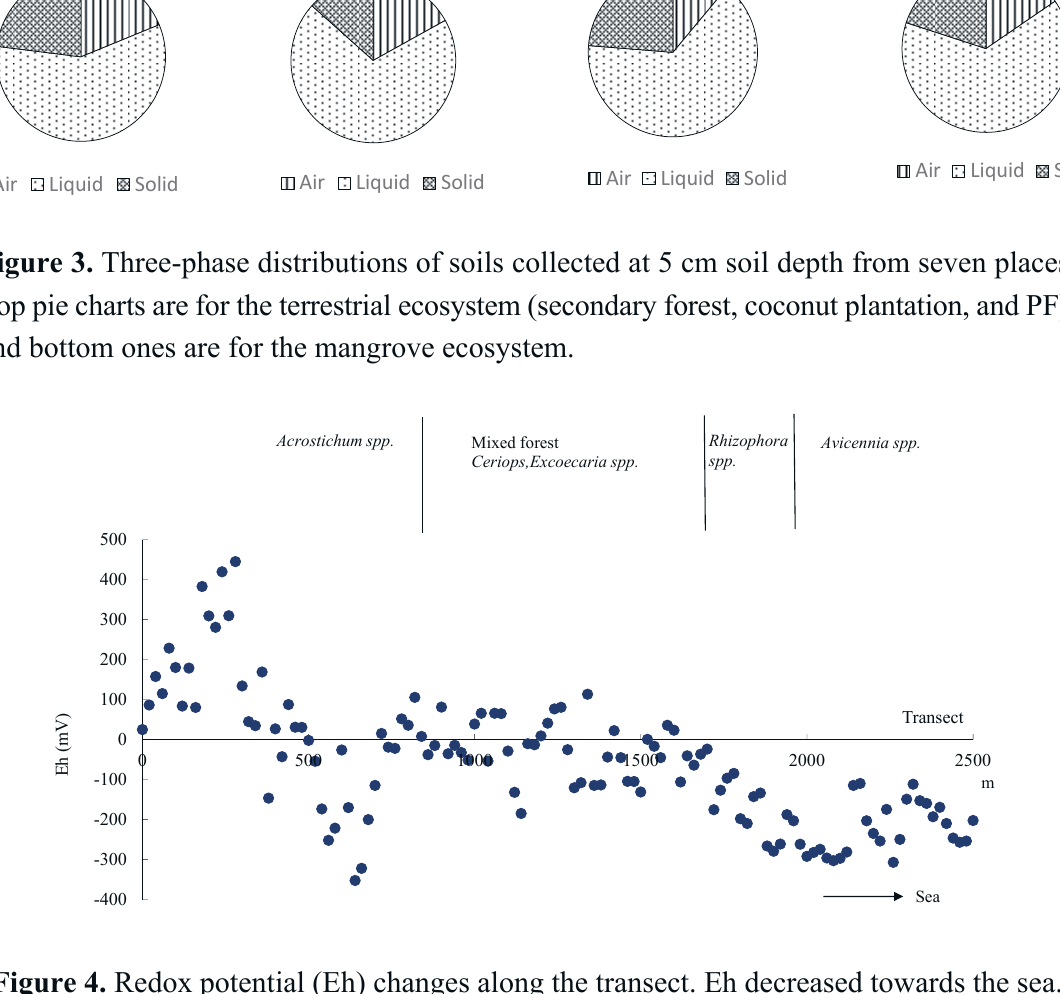
Figure 4. Redox potential (Eh) changes along the transect. Eh decreased towards the